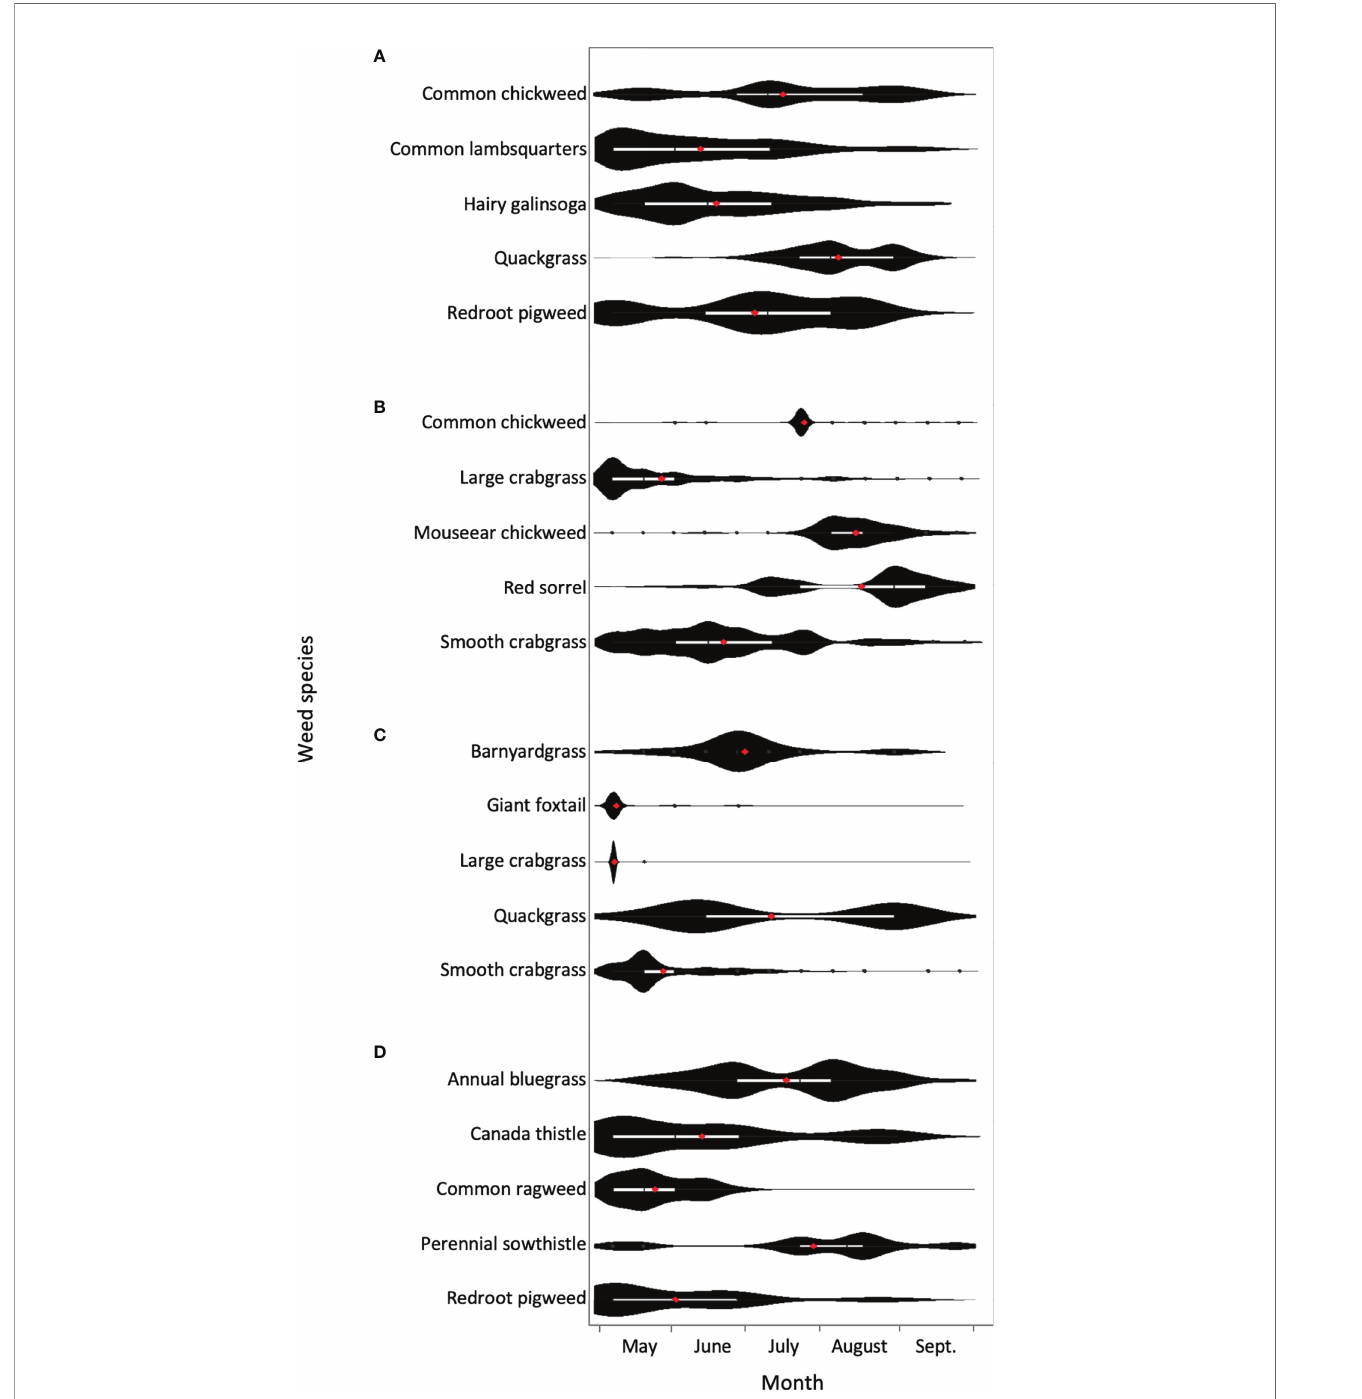
FIGURE 1 | Violin plots of emergence of the fi ve most abundant weeds following tillage on different dates and locations; Old Town, ME (A) ; Durham, NH (B) , Big Flats, NY (C) , and Aurora, NY (D) (adapted from Cordeau et al., 2017b). Box plots (white) are presented within violin plots (black) and means represented by red